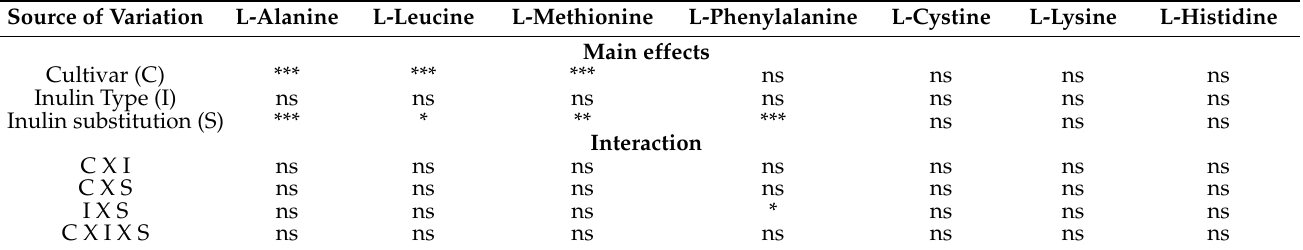
Table 6. ANOVA analyses for each aminoacid as affected by cultivar, inulin-type, and percentage of substitution.